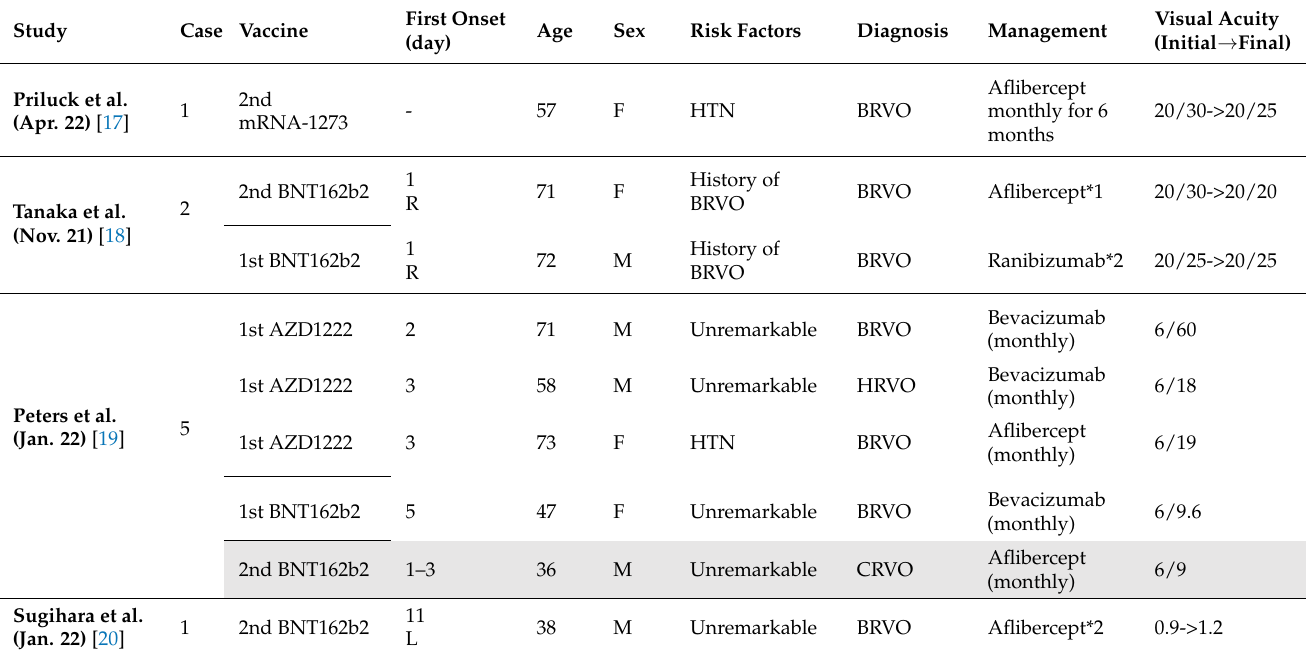
Table 2. Summary of studies that describe retinal vein occlusion (RVO) after COVID-19